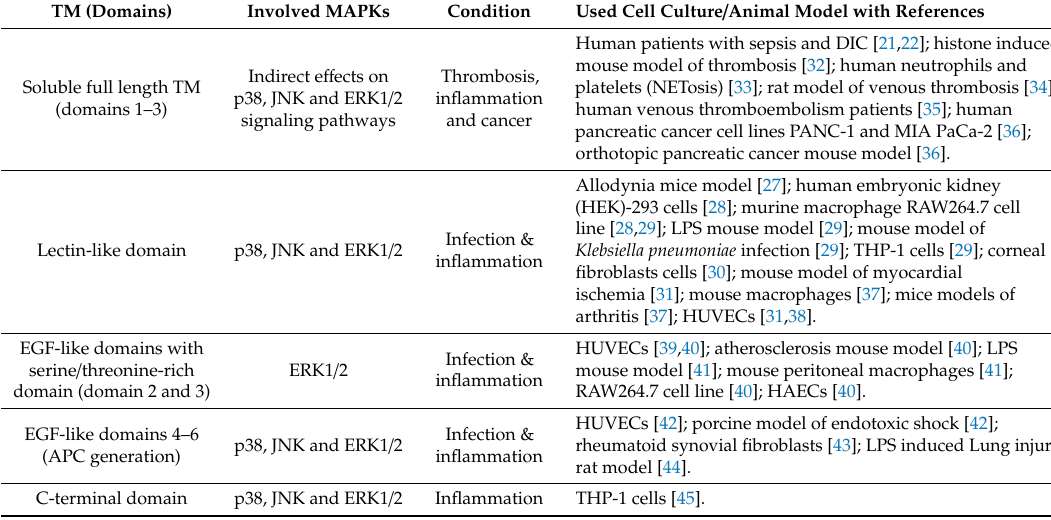
Table 1. Role of di ff erent TM domains in regulation of MAPK signaling pathways under various conditions of inflammation and